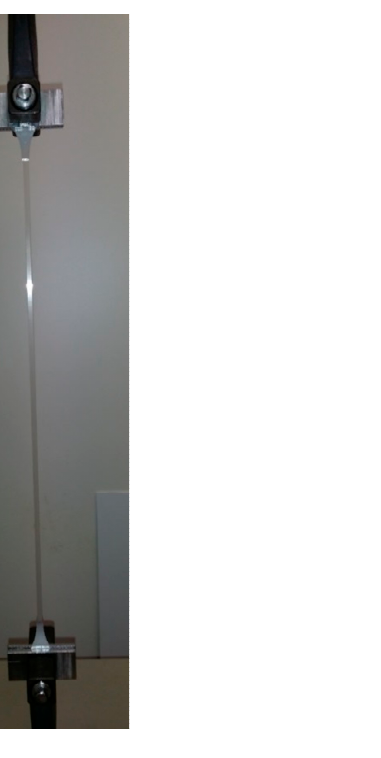
Figure 7. ISO-LLDPE (linear low-density polyethylene) specimen during tensile test.